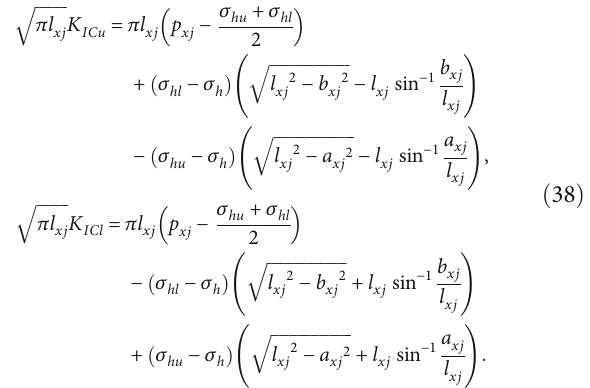
q ffiffiffiffiffiffiffiffiffiffiffiffiffiffi l 2 − a 2 yi q ffiffiffiffiffiffiffiffiffiffiffiffiffiffi l 2 − b 2 yi